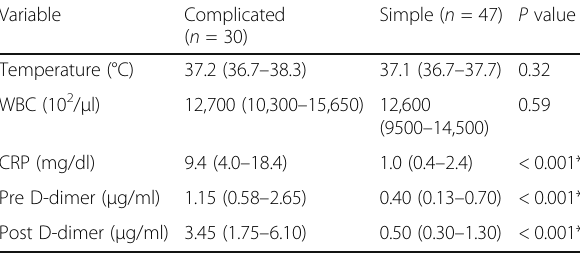
Table 3 Comparison of the inflammatory biomarkers